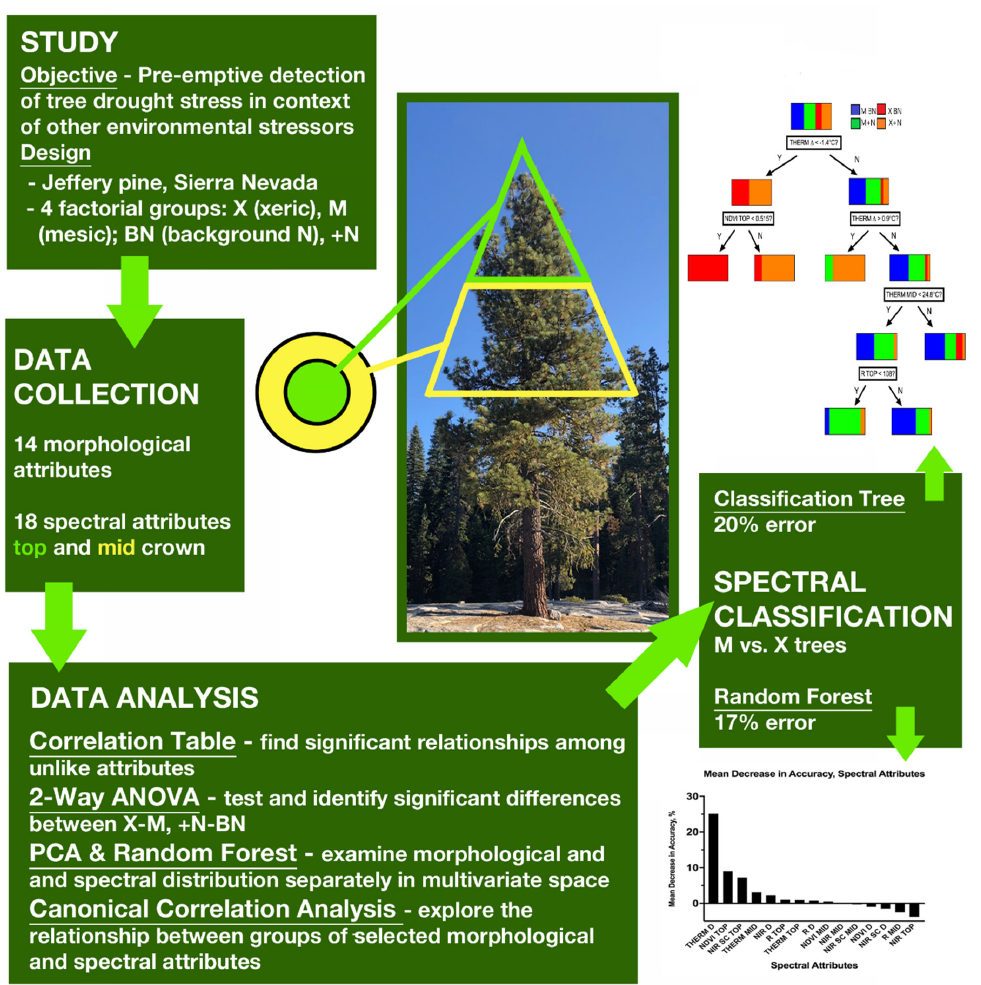
Figure 3. Diagram of study design, data collection, approach to data analysis, and classification of trees based on selected spectral traits using classification tree and random forest models.